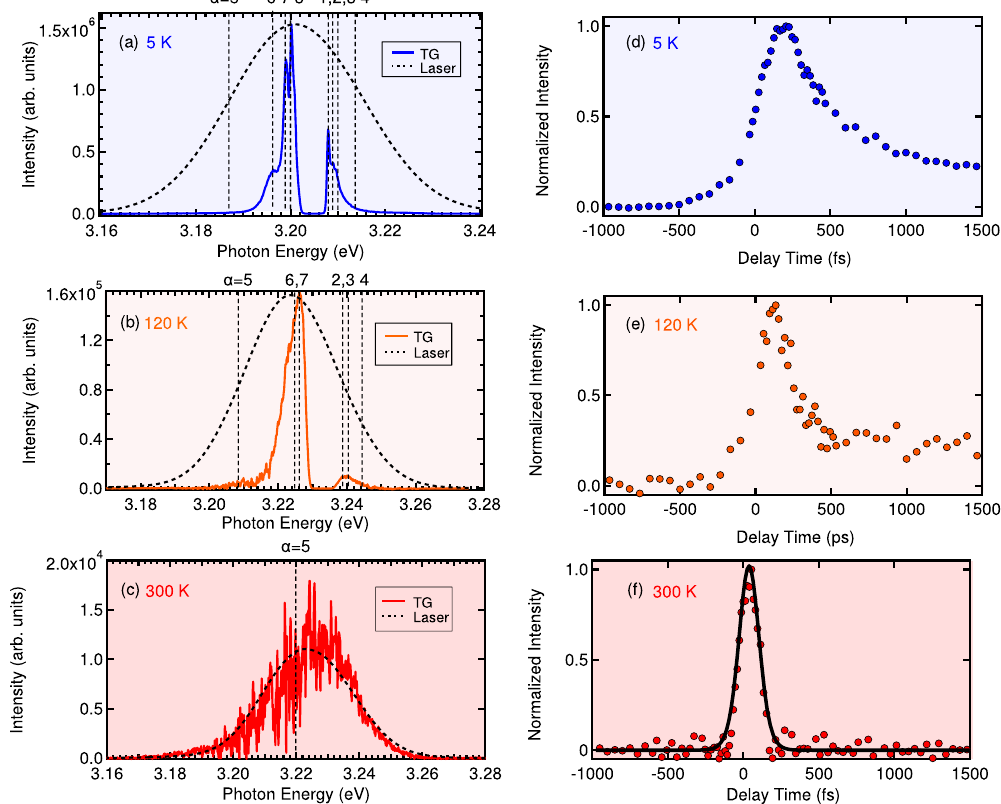
Figure 3. ( a – c ) The TG spectra at 5 K, 120 K, and 300 K for the same CuCl thin film as those in the PL measurement. The photon energy range in each figure is set by considering the shift of excitonic energies estimated from the fitting of the reflectance spectra. The vertical dotted lines indicate the eigenenergies of exciton–light coupled modes { α }. ( d – f ) Delay time dependence of TG signal intensity corresponding to the respective left panels. The dashed line in ( f ) represents the fitting of a single-exponential function convoluted by the excitation laser profile.